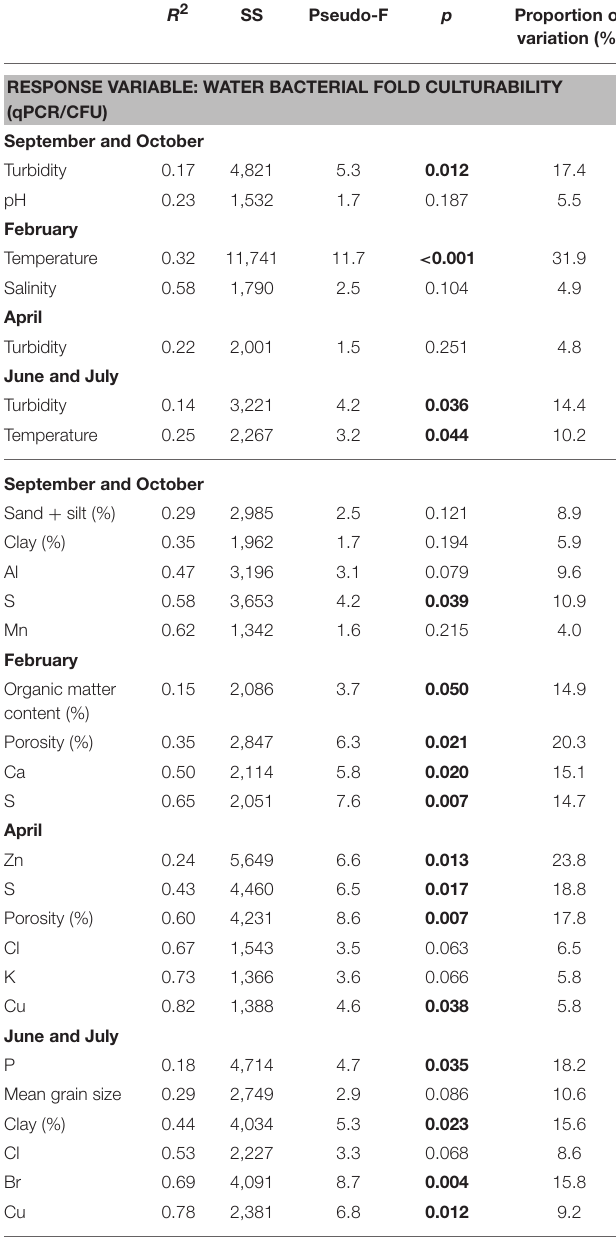
TABLE 2 | DistLM sequential tests. R 2 SS Pseudo-F p Proportion of